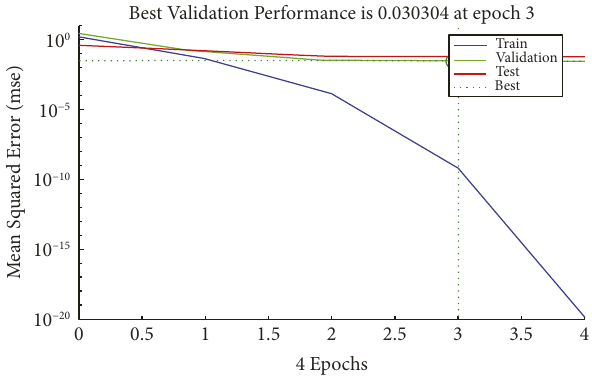
Figure 5: Performance plot of training network.